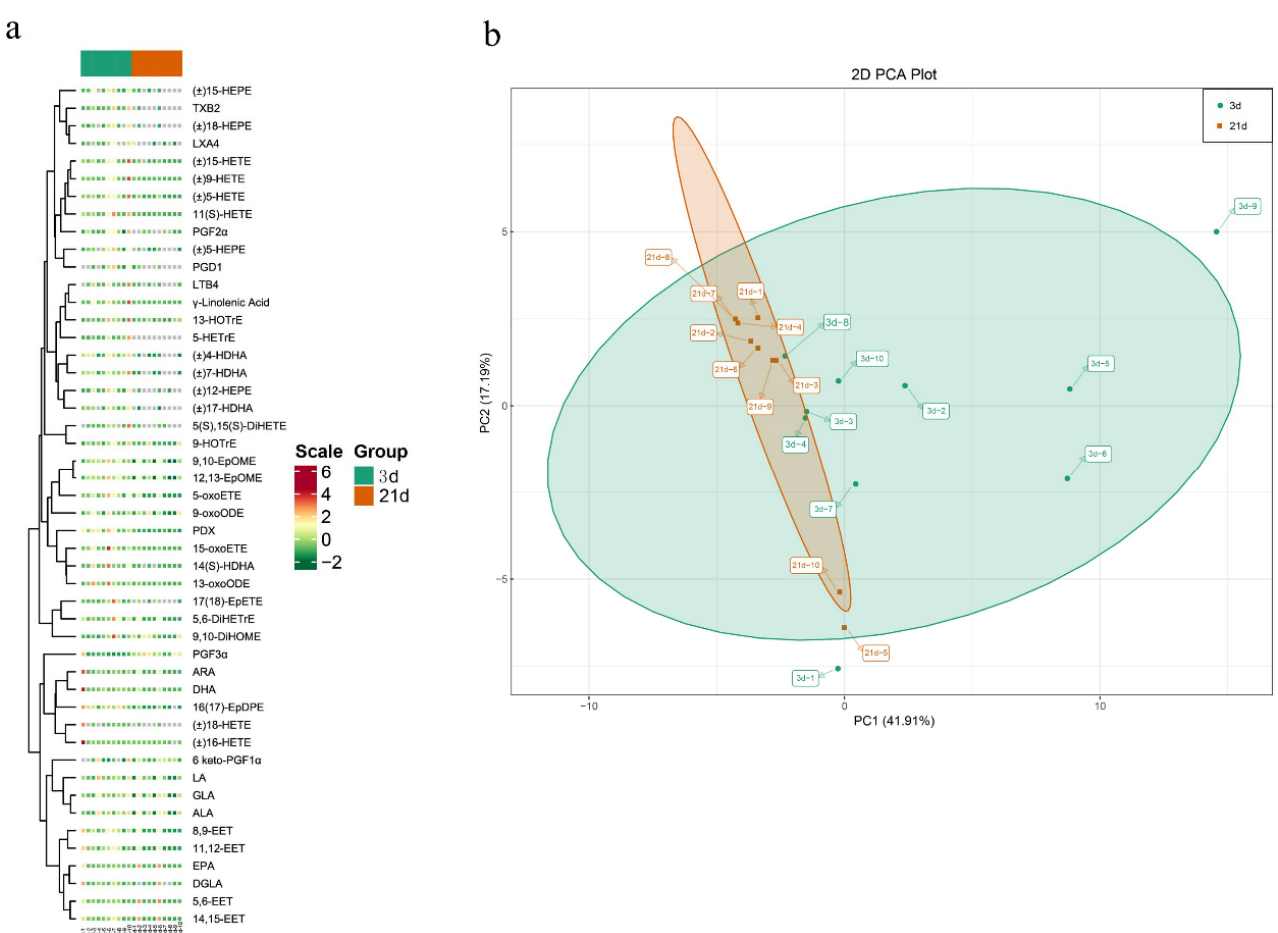
Figure 2. Oxylipins were detected in feces of suckling piglets at birth day 3 and day 21 ( n = 10). ( a ) Heat map hierarchical clustering of detected all metabolites in this study. Hierarchical trees were drawn based on detected metabolites in feces of suckling piglets at birth day 3 and day 21. The columns correspond to feces at 3d and 21d postnatally, while the rows represent different metabolites. ( b ) Principal component analysis for metabolites identified in feces.